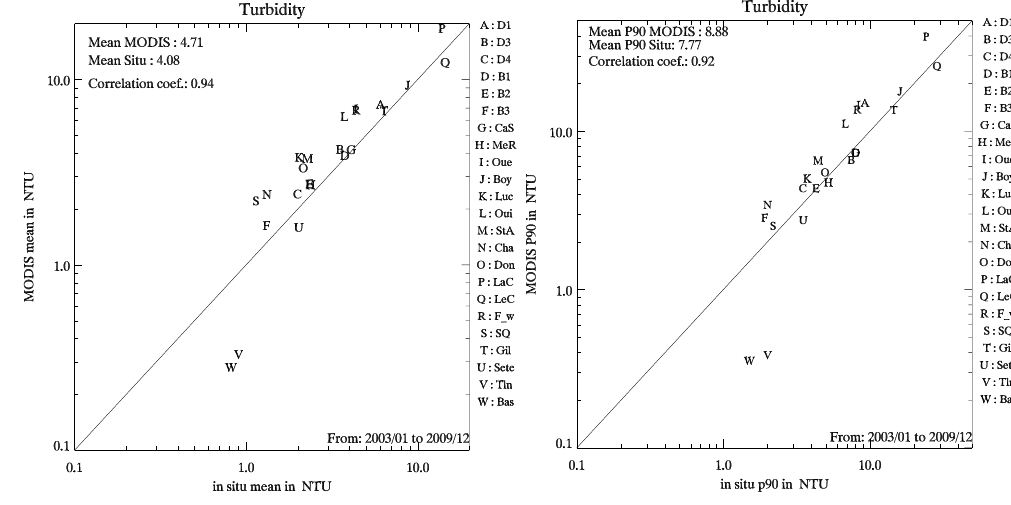
Fig. 14. Annual average (a) and P90 (b) of the MODIS and in-situ